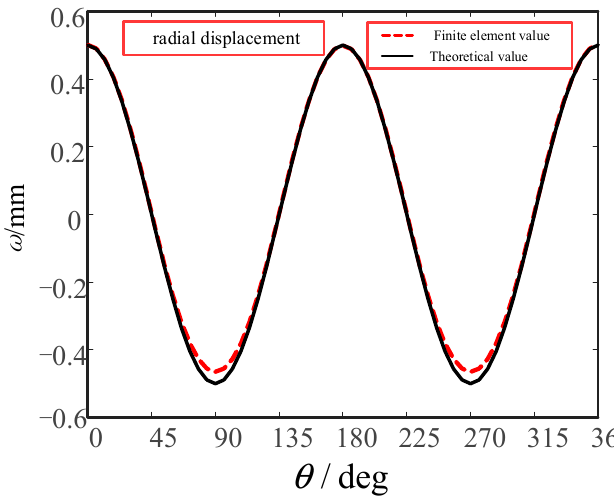
Figure 13. Comparison of the radial displacement of the flexible wheel neutral layer.